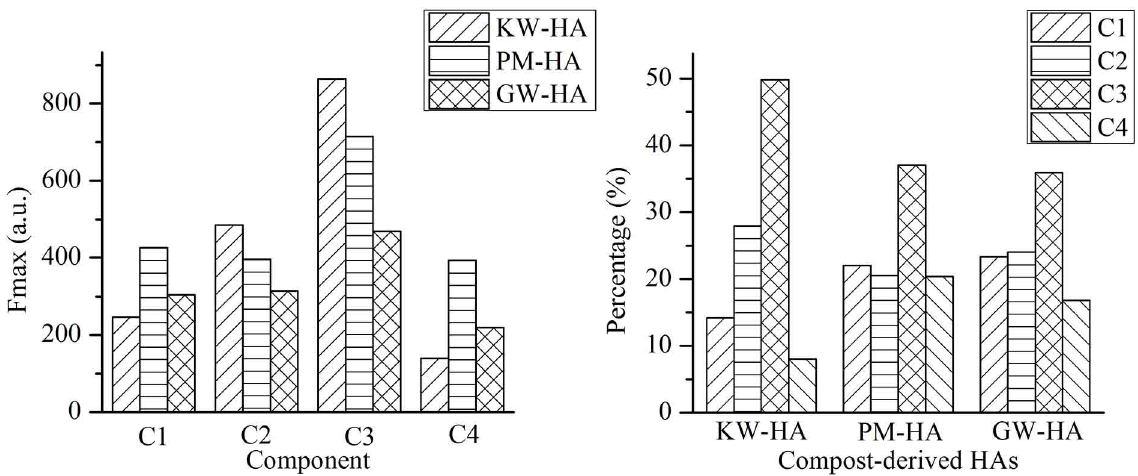
Figure 3: Fmax values of the four PARAFAC-derived components in three HAs without adding heavy metals and each component corresponding percentage in three